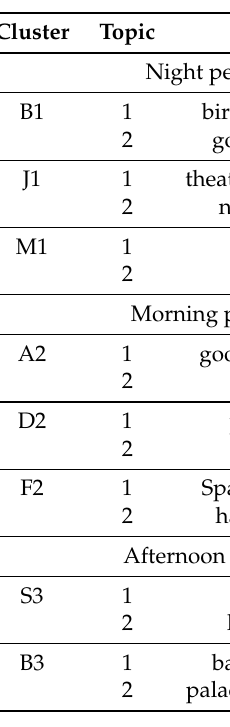
Table 7. Cluster topic samples from the MD dataset.